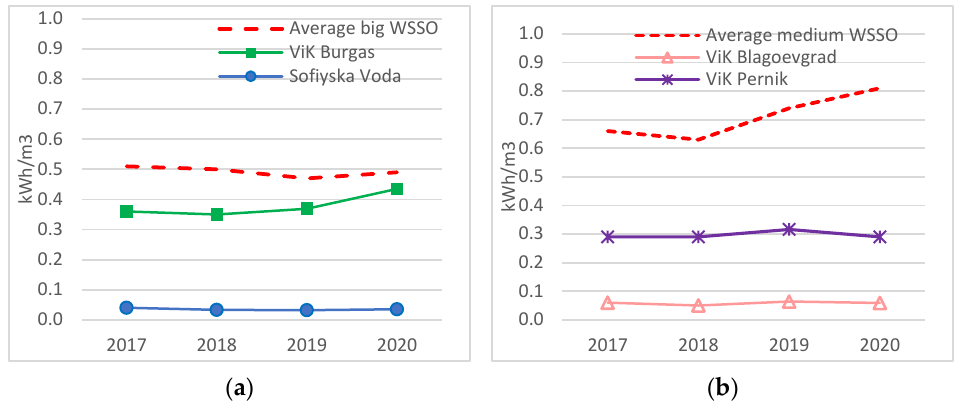
Figure 6. Energy demand in kWh per m 3 for water intake, treatment, and distribution: ( a ) Sofiyska Voda and ViK Burgas; ( b ) ViK Blagoevgrad and ViK Pernik .